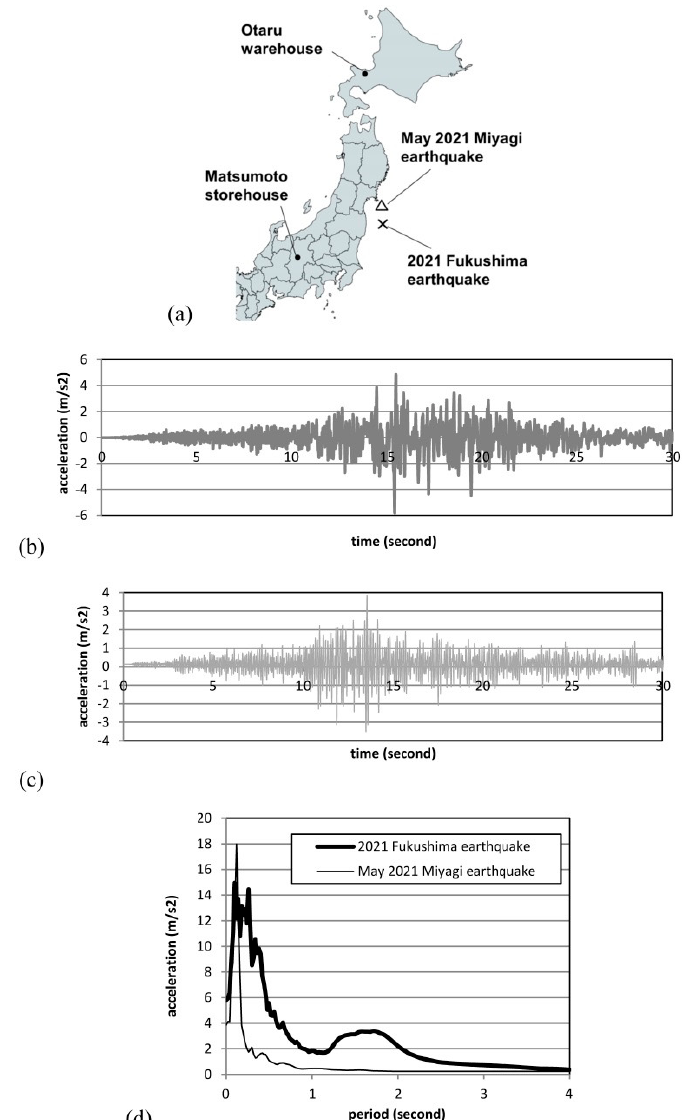
Figure 4. Occurrence of earthquakes during the monitoring period: ( a ) locations of the two earth- quakes; acceleration time history of the 2021 Fukushima earthquake ( b ) and of the May 2021 Miyagi earthquake ( c , d ) response spectra (( a ) originally from [65], modified by the authors, ( b – d ) from [66]).